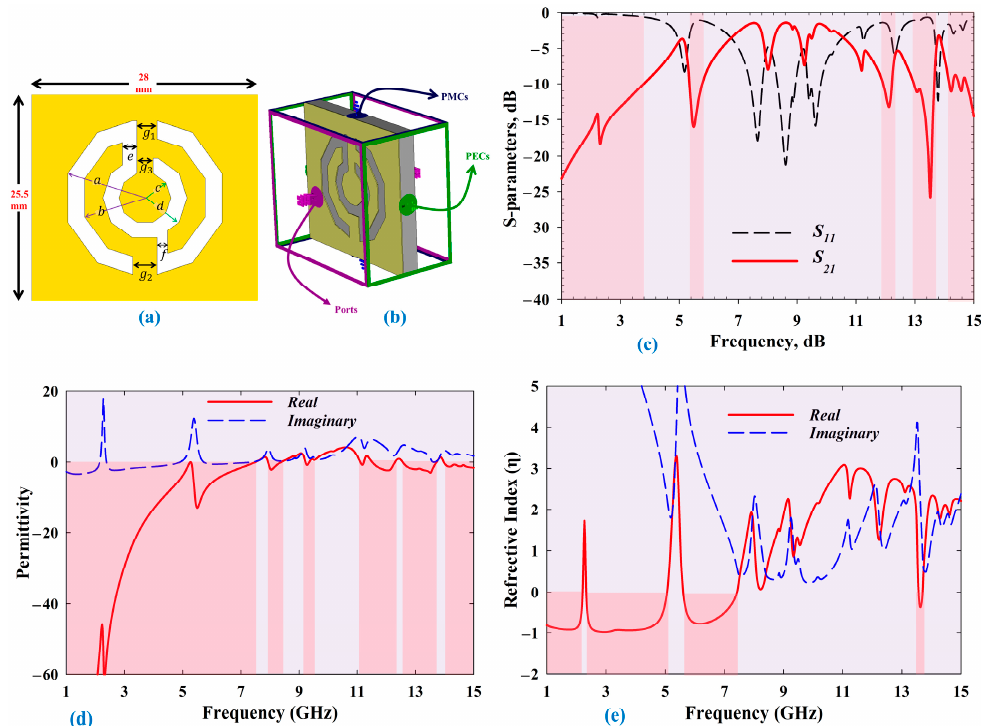
Figure 2. MTM unit cell model and simulated results under WP1: ( a ) schematic of the proposed unit cell, ( b ) 3D view of the MTM simulation setup, ( c ) simulated S-parameters, ( d ) permittivity, and ( e ) refractive index.